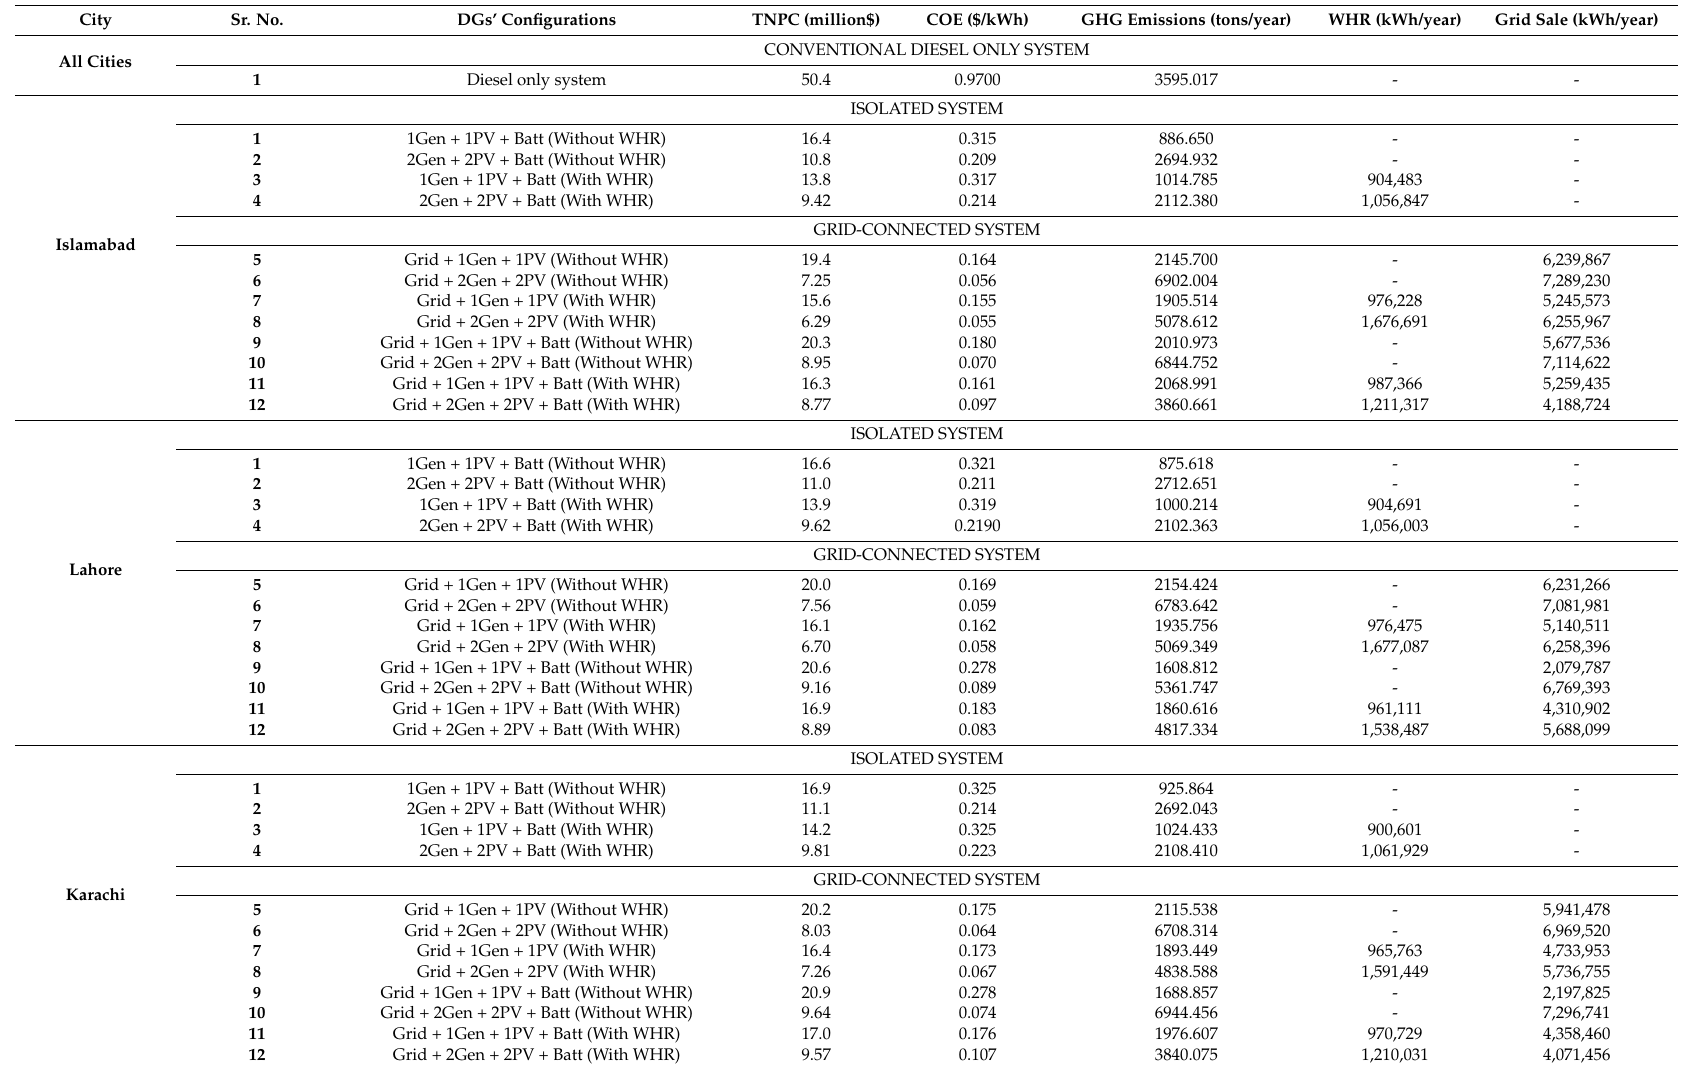
Table 6. Multiple objectives for Islamabad, Lahore and